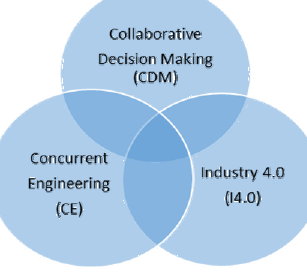
Figure 7. Relation between CMD, CE and I4.0. Table 1. Main characteristics underlying CDM in CE and